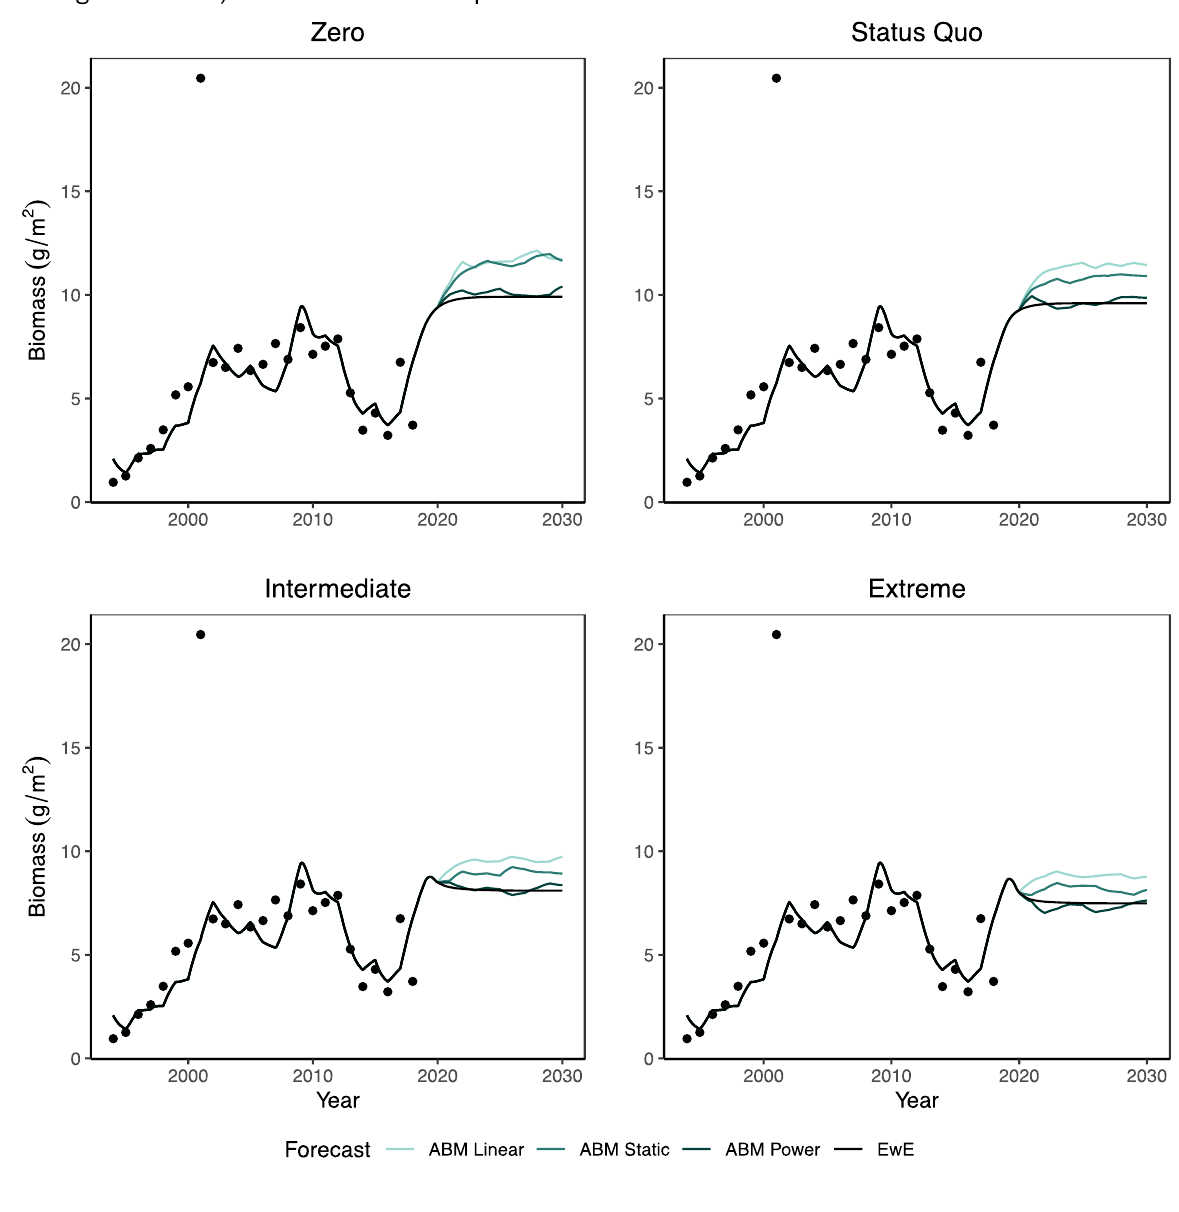
Fig. A1.1. Piscivorous fish biomass forecasts of the coupled social-ecological model for the four scenarios of commercial forage fish harvest compared to the food web (EwE) forecast. The different color lines represent the three variations of abundance-catch relationship in the social- ecological model, and the black line represents the stand-alone food web